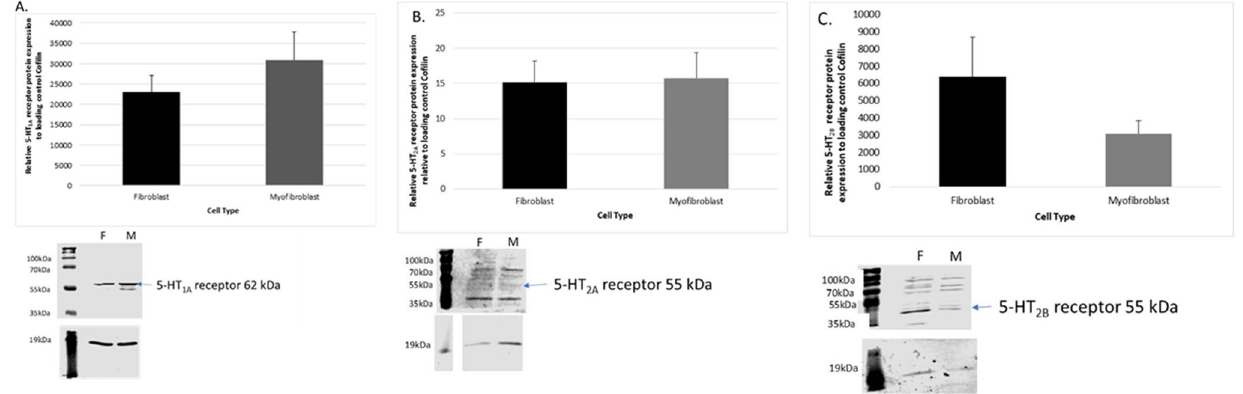
Figure 2. Comparison of the relative expression of serotonin 5-HT 1A receptor protein (62 kDa) in cardiac fibroblast and myofibroblast cells. ( A ) Represents the relative expression of serotonin 5-HT 1A receptors in cardiac fibroblast and myofibroblast cells. Comparison of the relative expression of serotonin 5-HT 2A receptor protein (55 kDa) in cardiac fibroblast and myofibroblast cells. ( B ) Represents the relative expression of